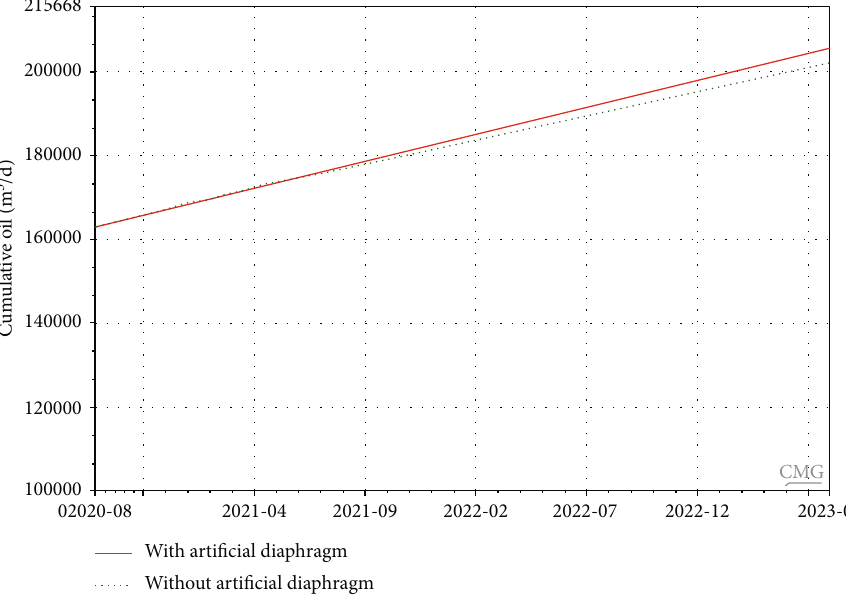
Figure 20: E ff ect of arti fi cial diaphragm on increasing production in the well